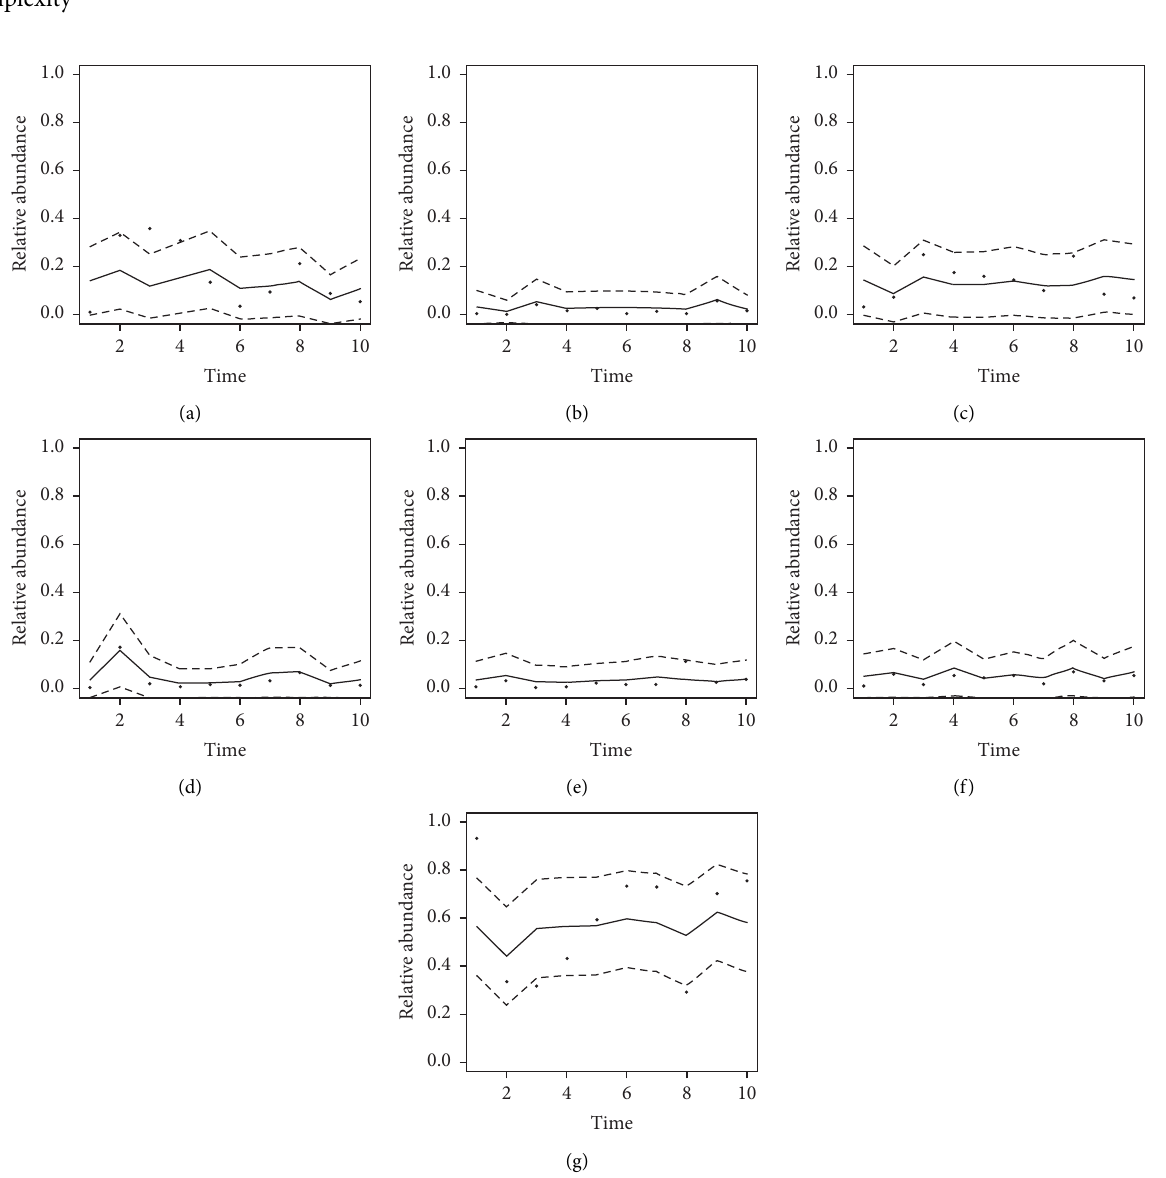
������� 􏽰 Var ( y it ) . (a) Bacteroidaceae.